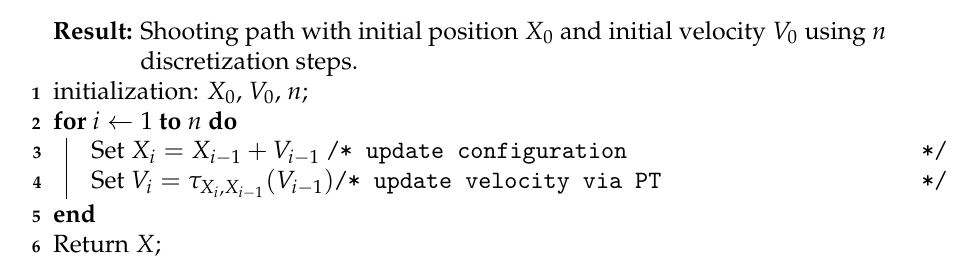
Algorithm 2: shooting